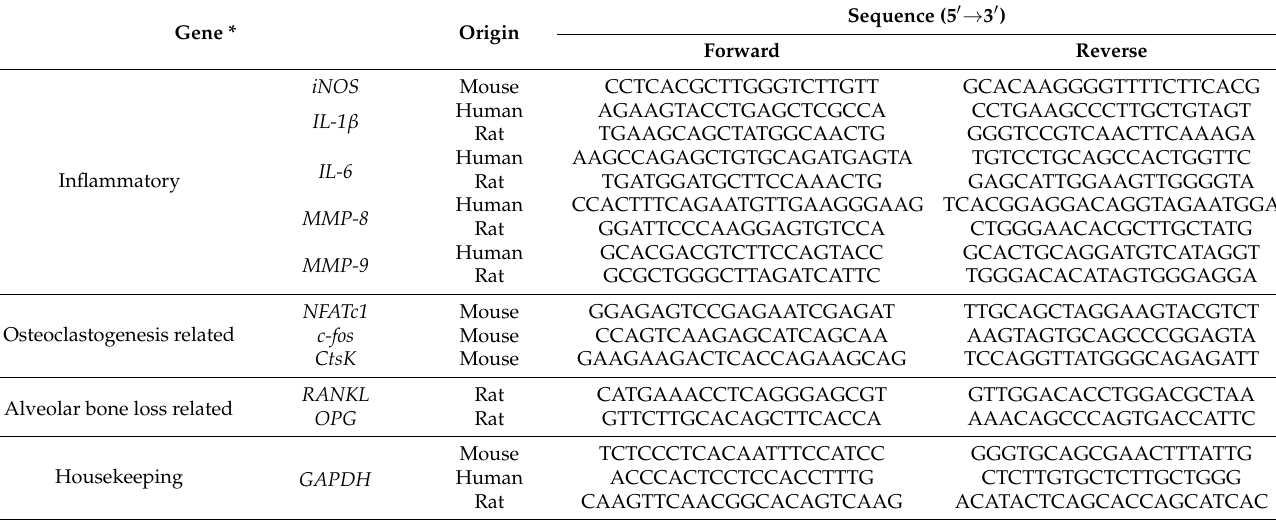
Table 1. Primer sequences used for